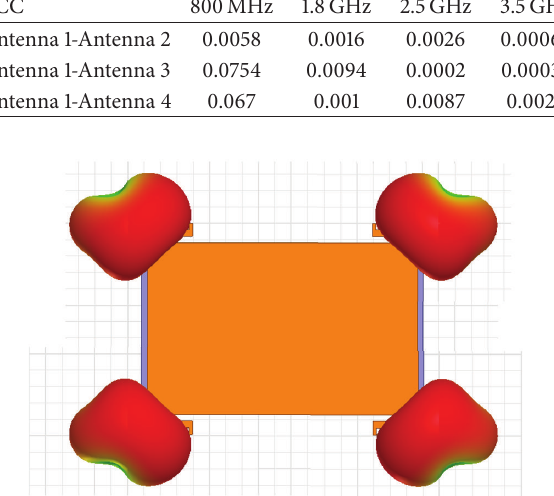
Figure 10: 3D radiation patterns at 800 MHz when each antenna is independently fed.